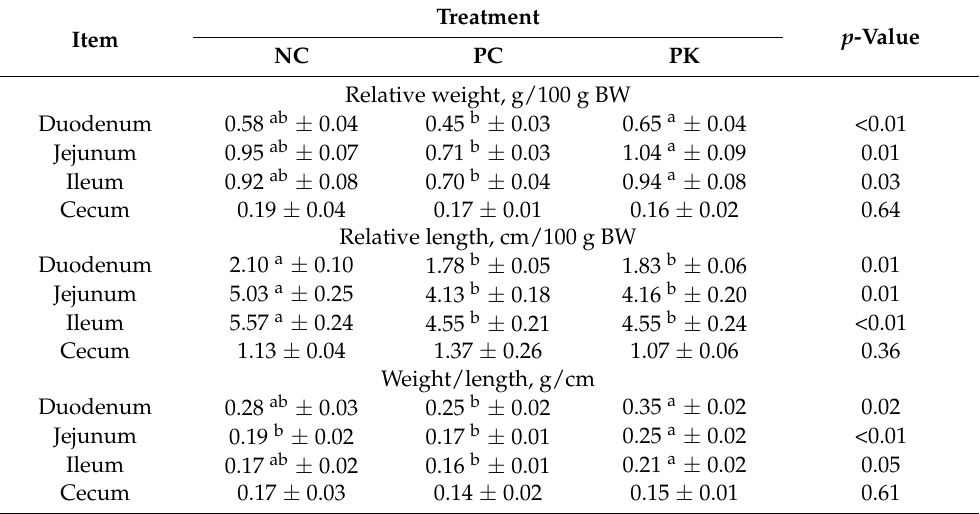
Table 4. Dietary supplemental effect of P. konkukensis on intestinal weight and length in broilers.